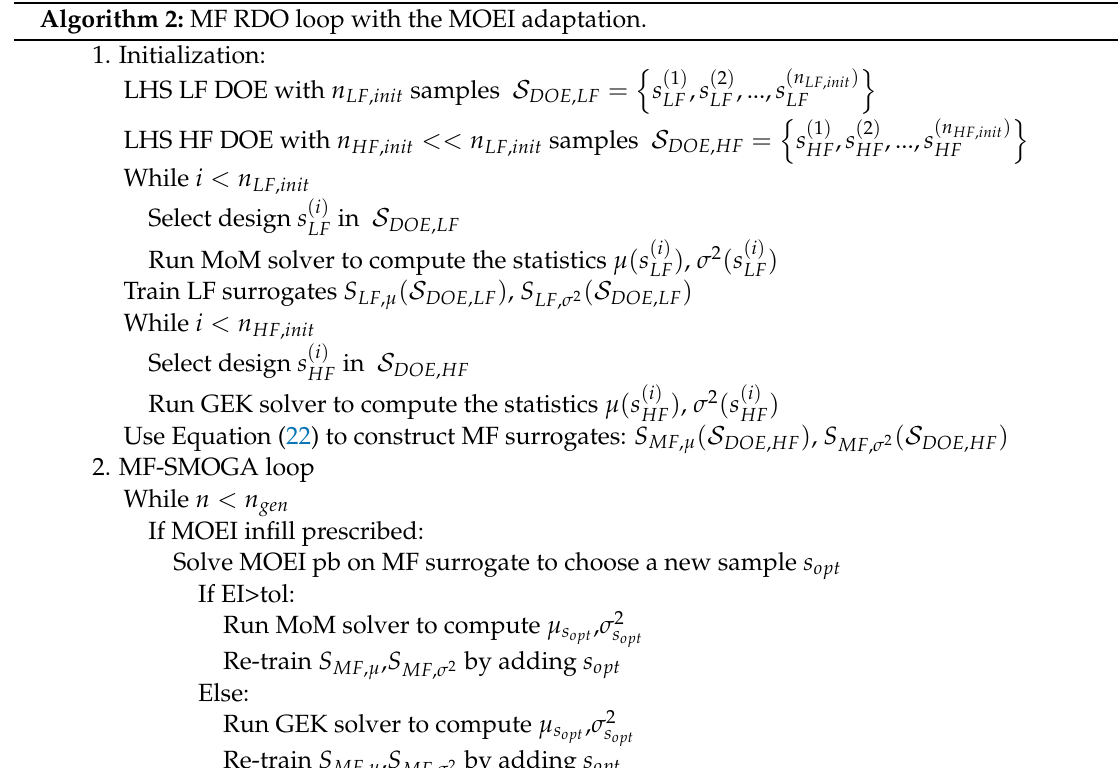
Algorithm 2: MF RDO loop with the MOEI